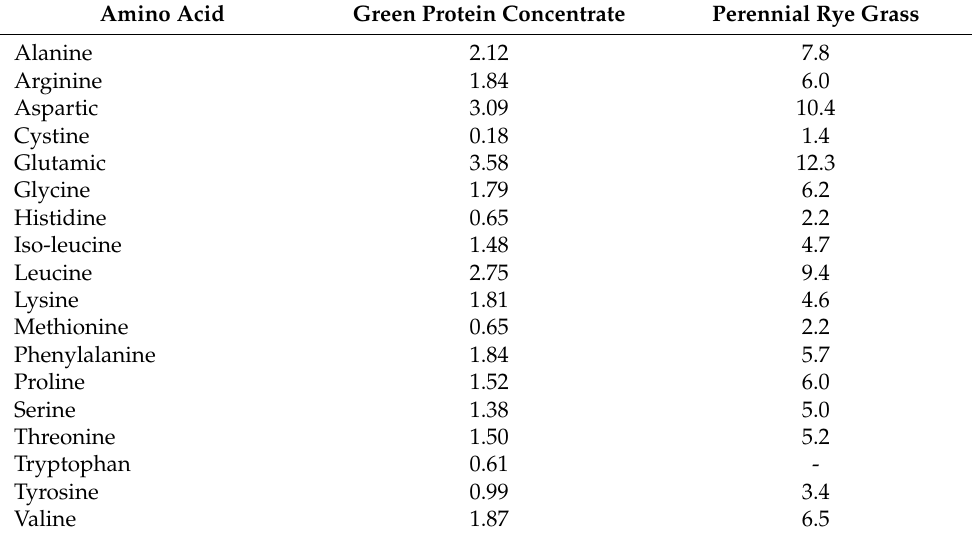
Table 4. Amino acid profile of green protein in comparison with perennial rye grass protein [40].